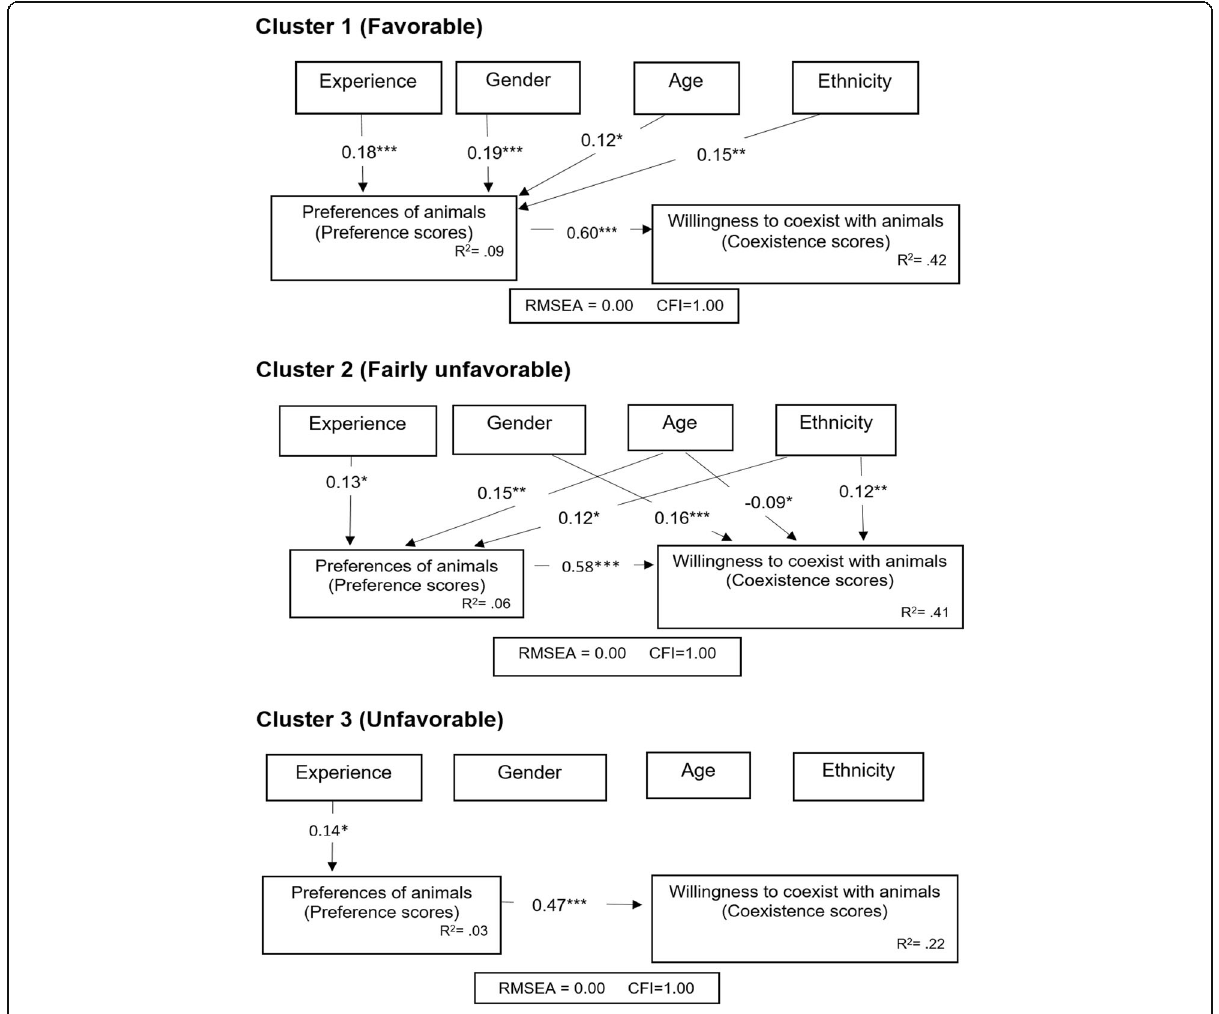
Fig. 4 The best SEM (clusters 1 – 3) with standardized estimates of parameters (non-significant paths omitted), predicting Preference and Coexistence for species grouped into clusters 1, 2, and 3 (see Fig. 1). Asterisks indicate significance levels (* p < 0.05; ** p < 0.01; *** p <